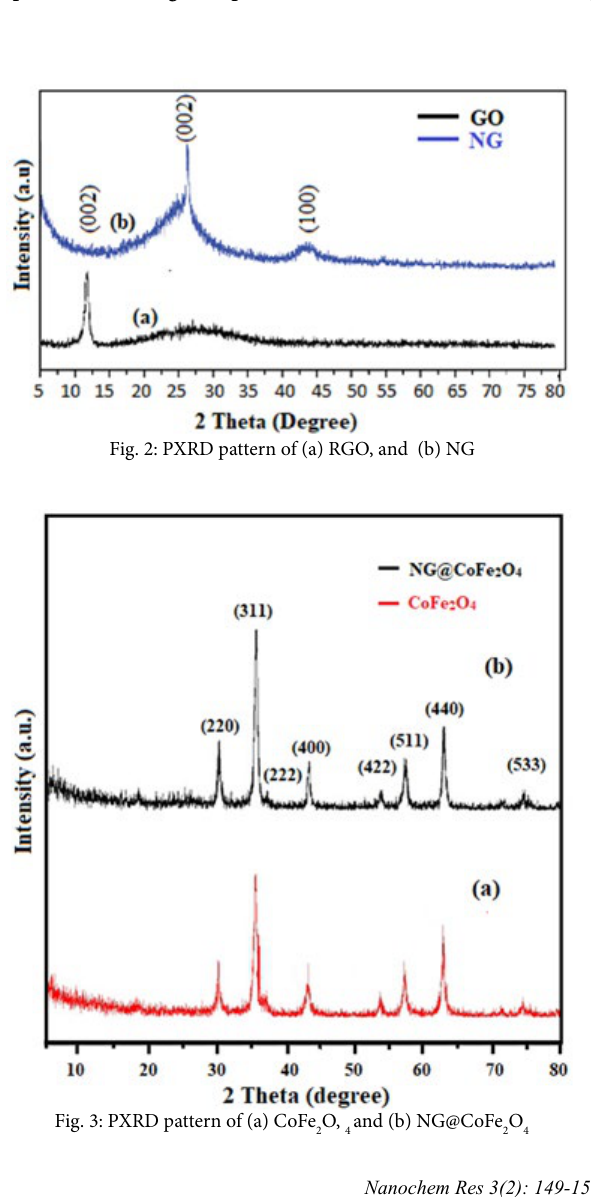
O, and (b) NG@CoFe 2 4